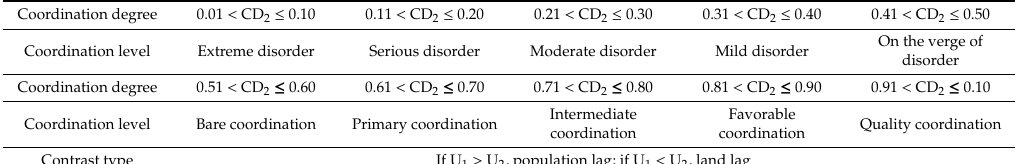
Table 2. Classification of the degree of coordination between land urbanization and population